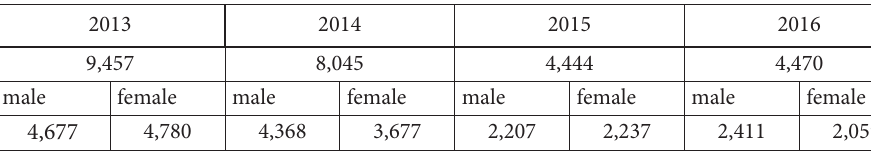
Table 1. Number of respondents for each year